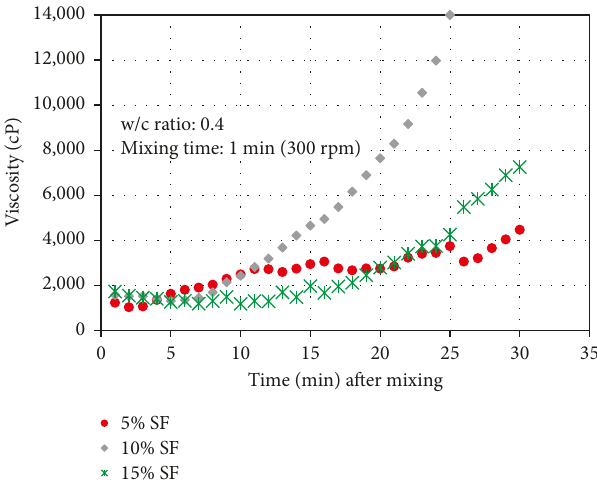
Figure 6: Viscosity with slag content (0.5w/c ratio). Figure 7: Viscosity with silica fume content (0.4w/c ratio).